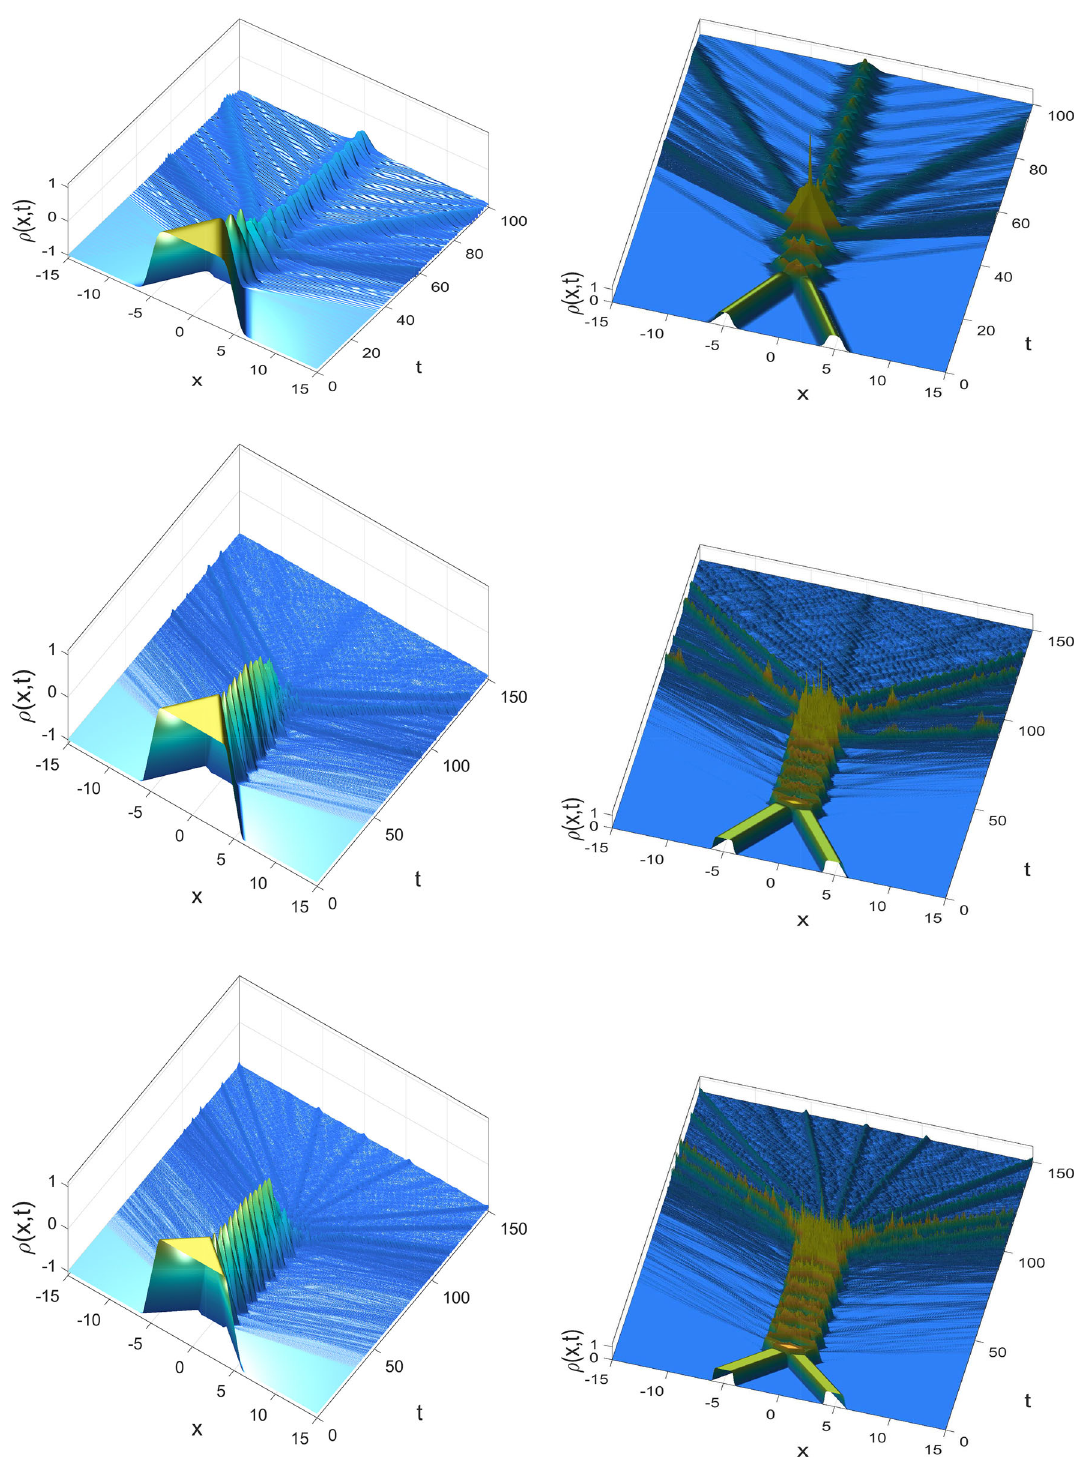
Fig. 9 Top to bottom: moving oscillons generated for the cases n = 2 , 6 and